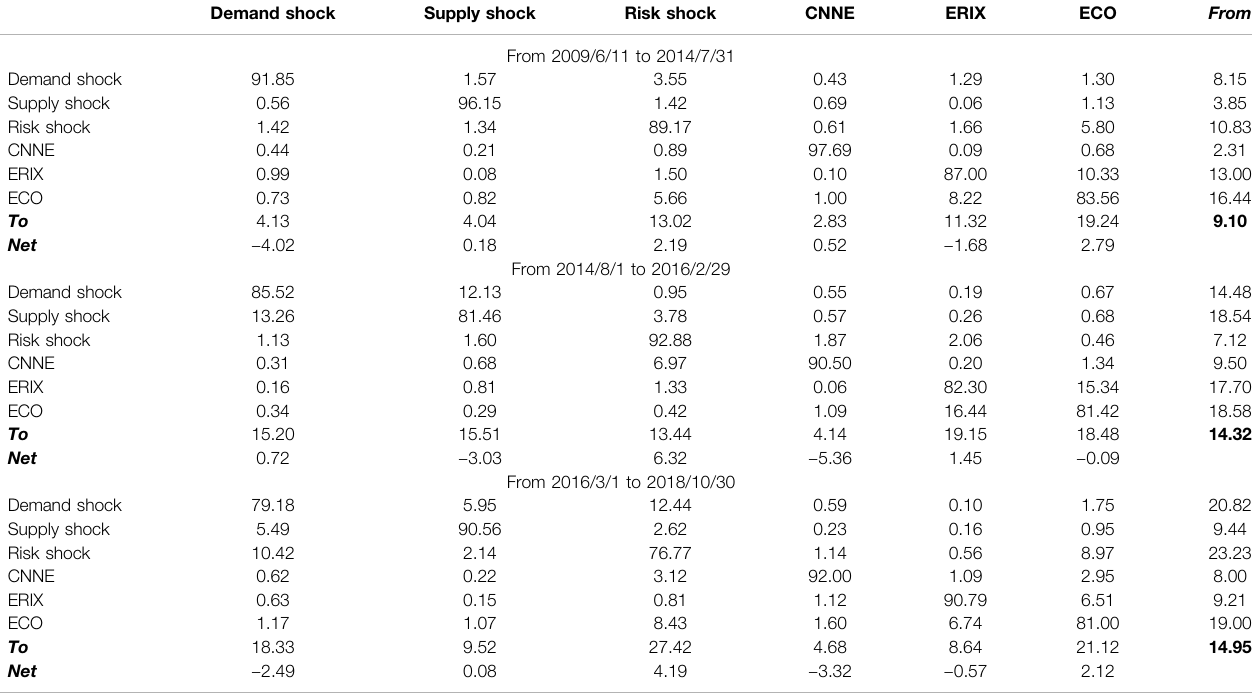
TABLE 5 | Oil shocks and new energy returns connectedness matrix for different sub-samples.